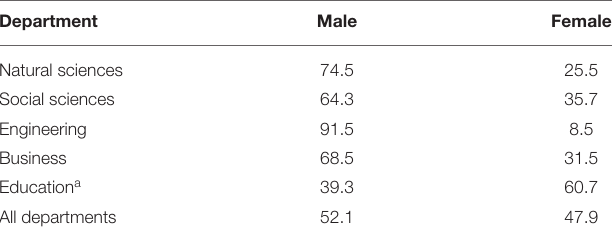
TABLE 1 | Percentage of gender differences in professorship by department, Fall